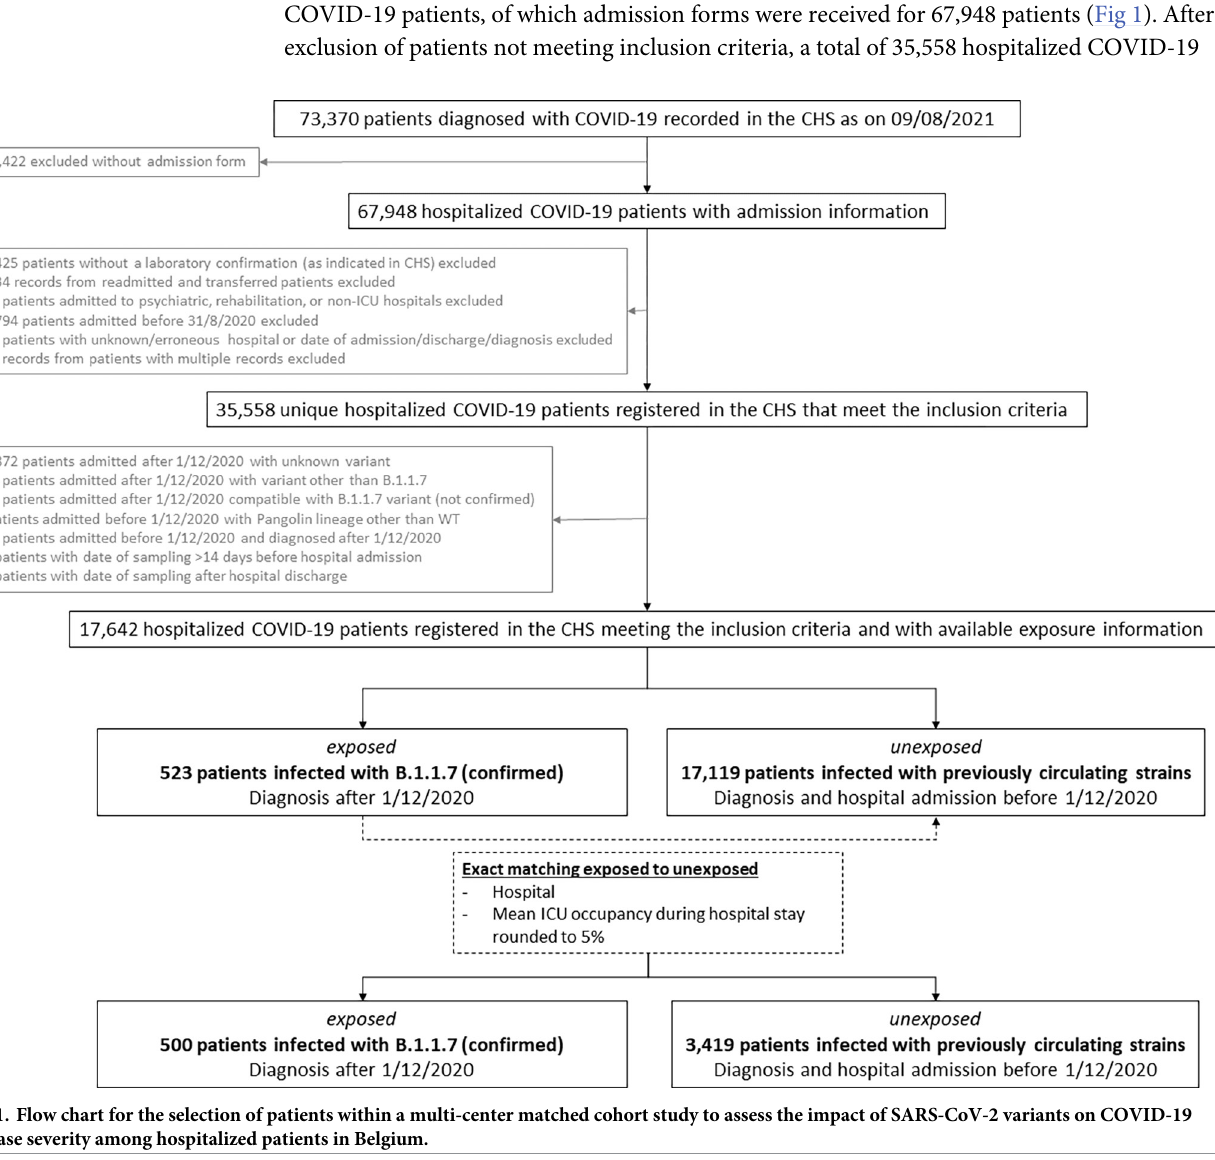
PLOS ONE | https://doi.org/10.1371/journal.pone.0269138 June 3,